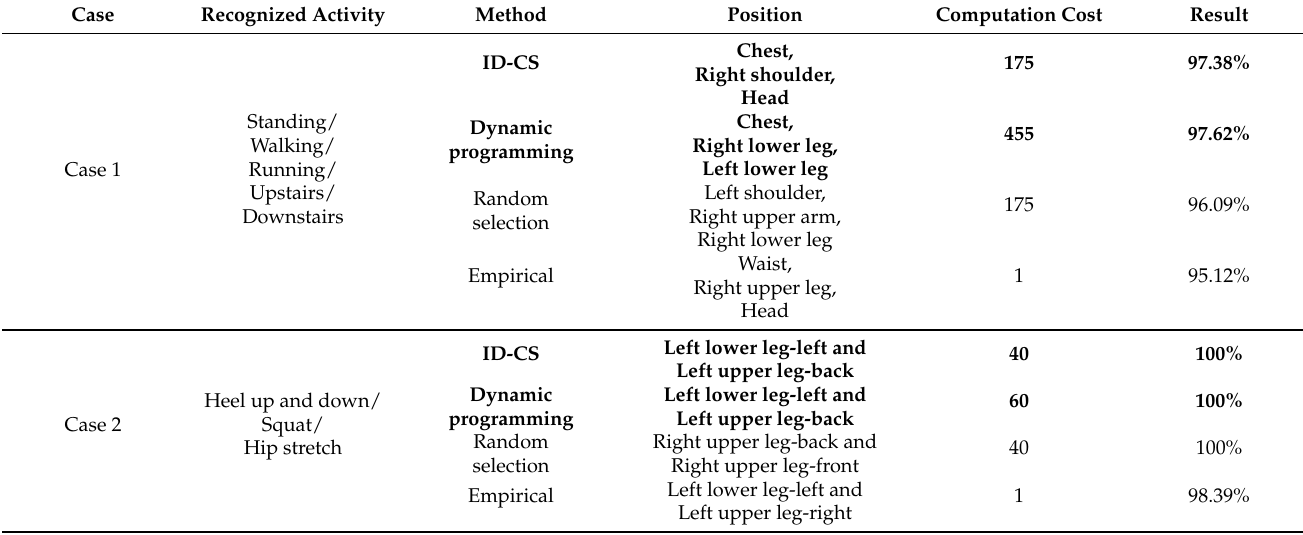
Table 2. Results of Case 1 and Case 2, which are both wearable types. Case 1 is a 3-sensor selection for 5 recognized activities. Case 2 is a 2-sensor selection from a virtual wearable distance sensor.